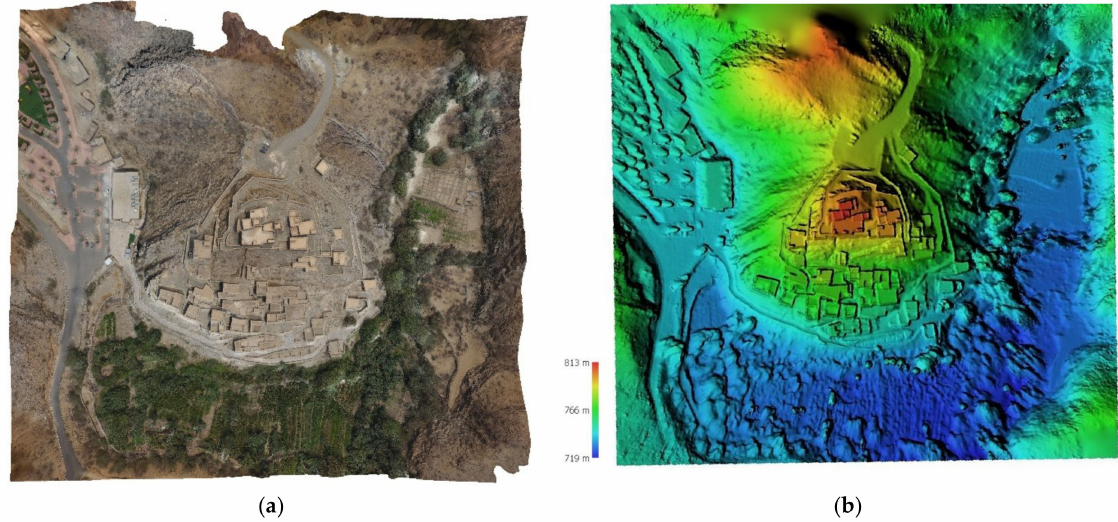
Figure 12. ( a ) Photogrammetric orthomosaic image; ( b ) UAV-SFM digital surface model.